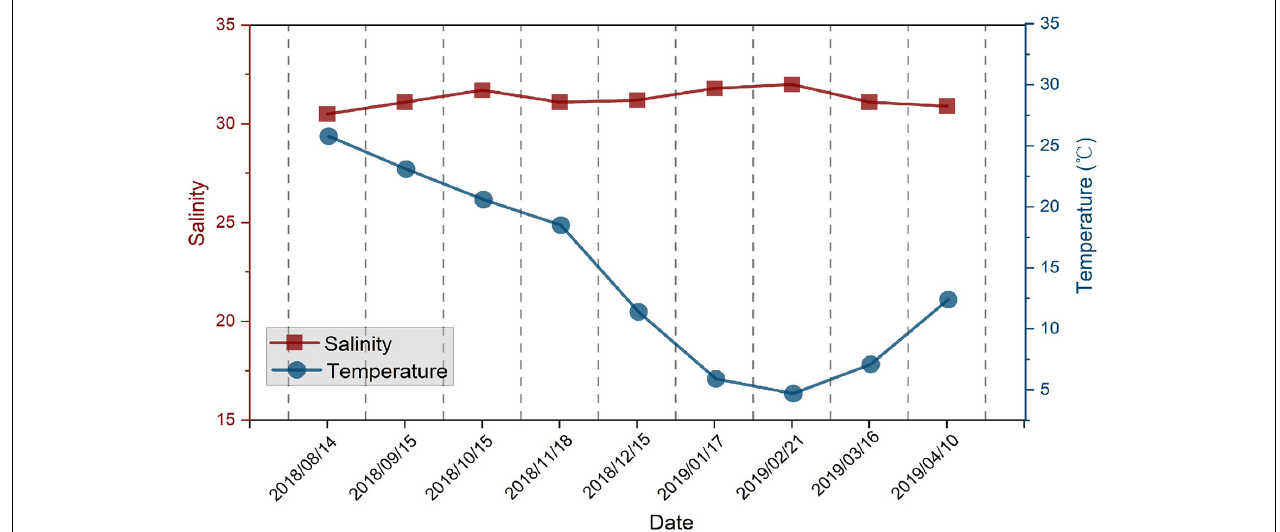
FIGURE 2 | Temperature and salinity at the Station in Jiaozhou Bay ( Figure 1B ) from August 2018 to April 2019.